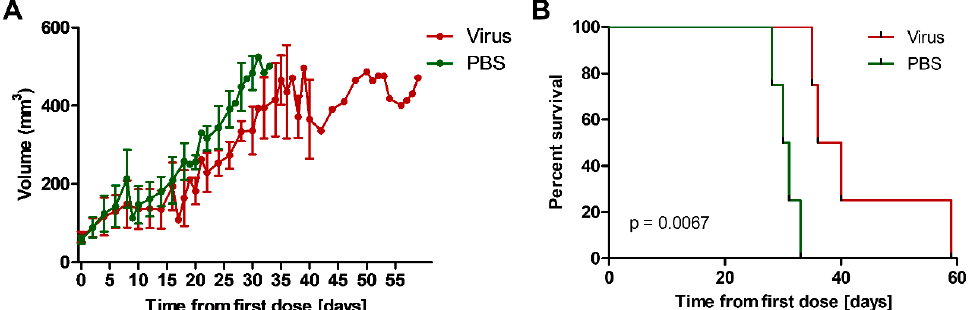
Figure 6 . In vivo HCT116 xenograft model shows a significant tumour growth delay. HCT116 cells (2 × 10 6 cells/mouse) were implanted subcutaneously into eight athymic nude mice. Tumours were monitored until they reached a volume of 50 mm 3 before randomisation into two groups. Four mice each were given three intravenous injections of either 0.5 × 10 10 virus particles EnAd-SA-Fluc or 50 µL phosphate buffered saline 48 h apart. One day after the final dose, all animals received 10 Gy of radiation to the tumour. Animal weights and tumour volumes were monitored until a tumour volume of 500 mm 3 was reached and the mice were sacrificed. ( A ) Tumour volumes and ( B ) survival curves for both groups. Significance was assessed using log-rank test. Graph shows mean of individual mice in each group ±